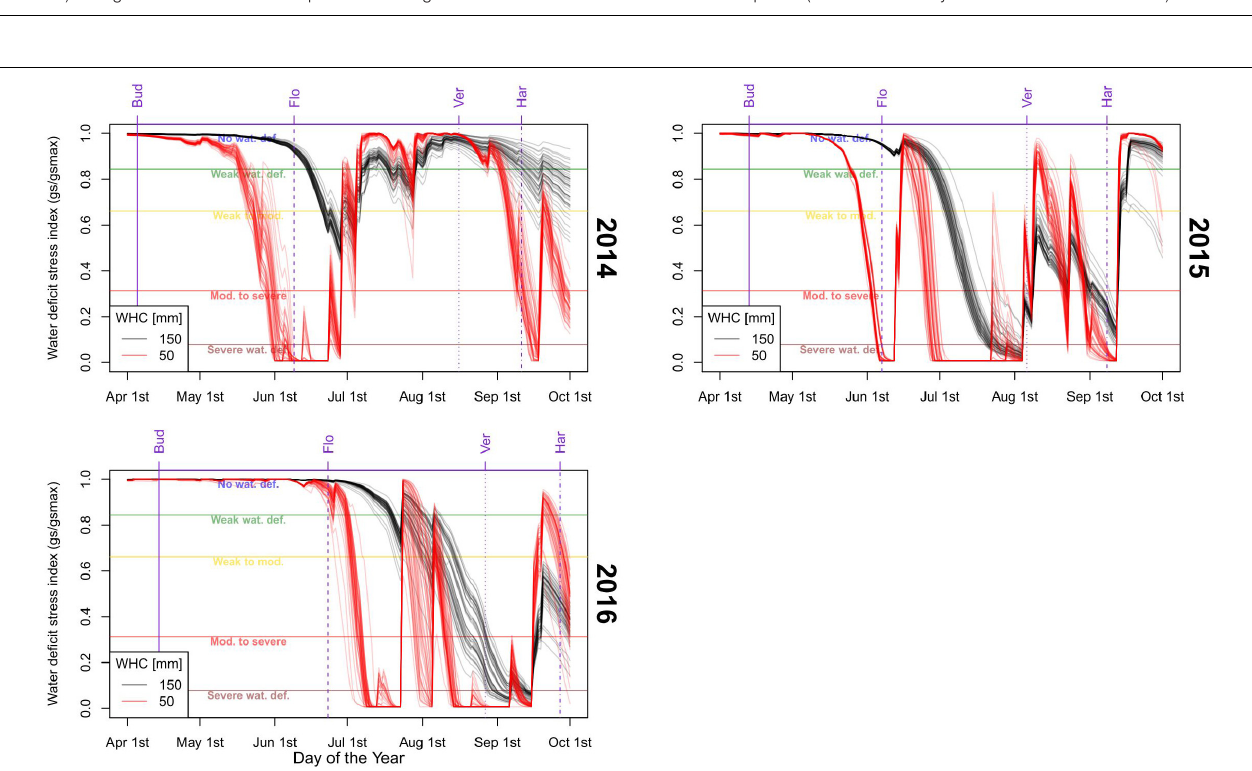
FIGURE 4 | Water deficit stress index daily values for low (50 mm) and high (150 mm) WHC soils. Each line corresponds to a simulation using rainfall value collected at one of the 45 rain gauges of Hydravitis local scale network. Threshold values between each class have been calculated from corresponding predawn leaf water potential values in table 1 of van Leeuwen et al. (2009), using the exponential relationship between fraction of transpirable soil water and predawn leaf water potentiel (Figure 3 in Lebon et al., 2003). The colored horizontal lines indicates the upper limit of water deficit classes as proposed by van Leeuwen et al. (2009).